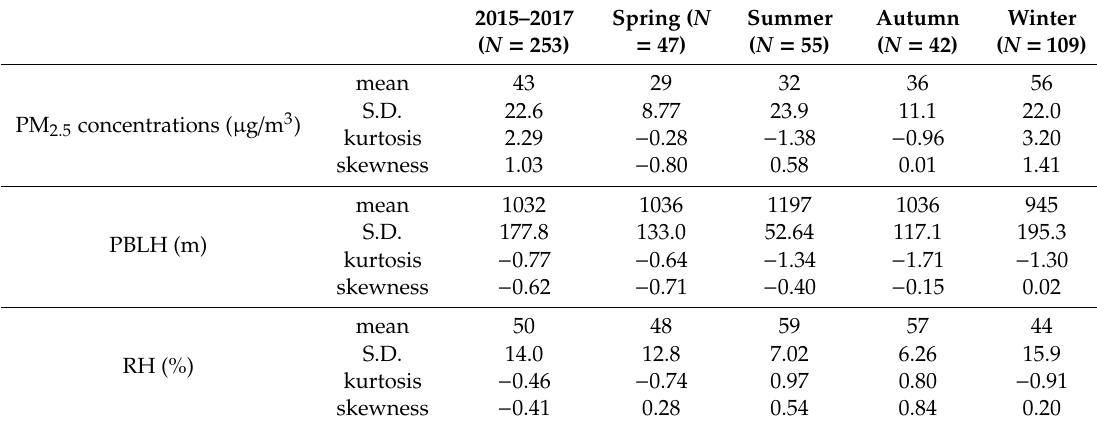
Table 1. Descriptive statistics of PM 2.5 concentrations, planetary boundary layer height (PBLH), and relative humidity